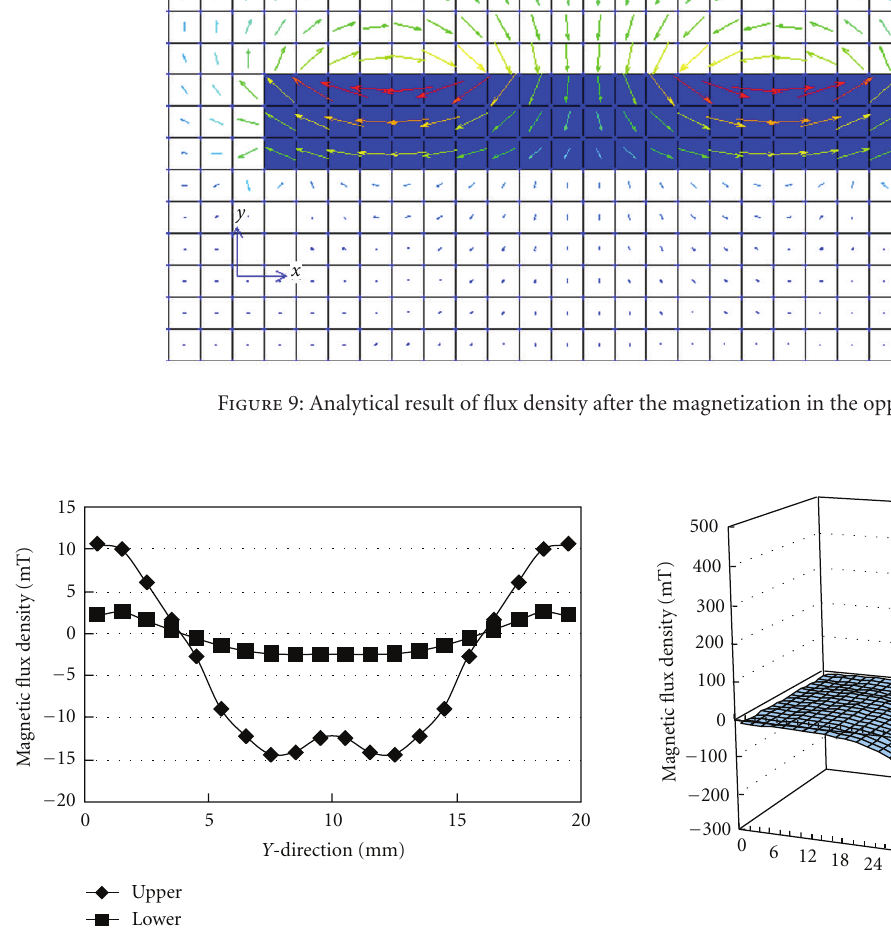
Figure 10: Magnetic flux density of upper part direction after the magnetization in the opposite direction.